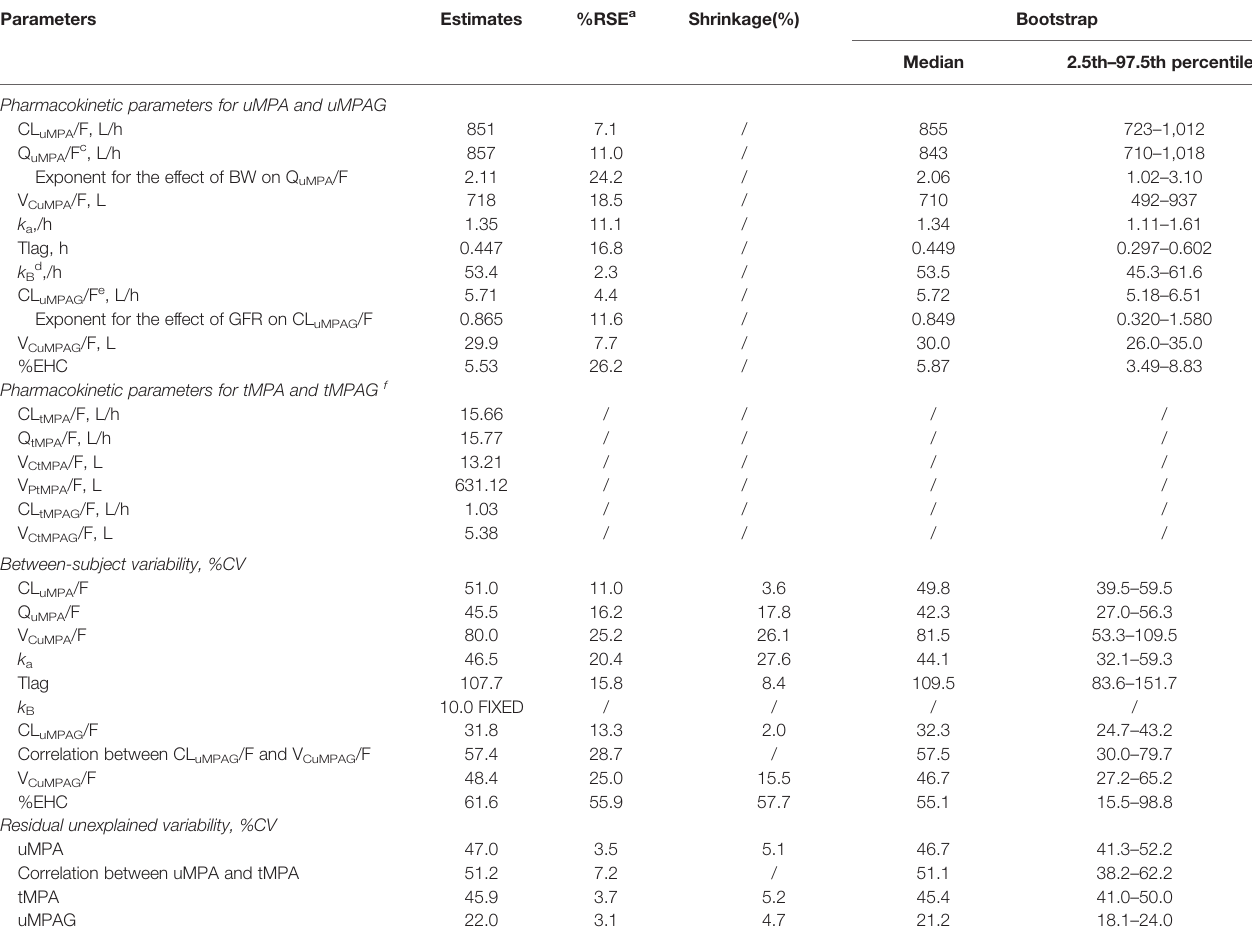
TABLE 2 | Pharmacokinetic parameter estimates for the fi nal model and Bootstrap results.